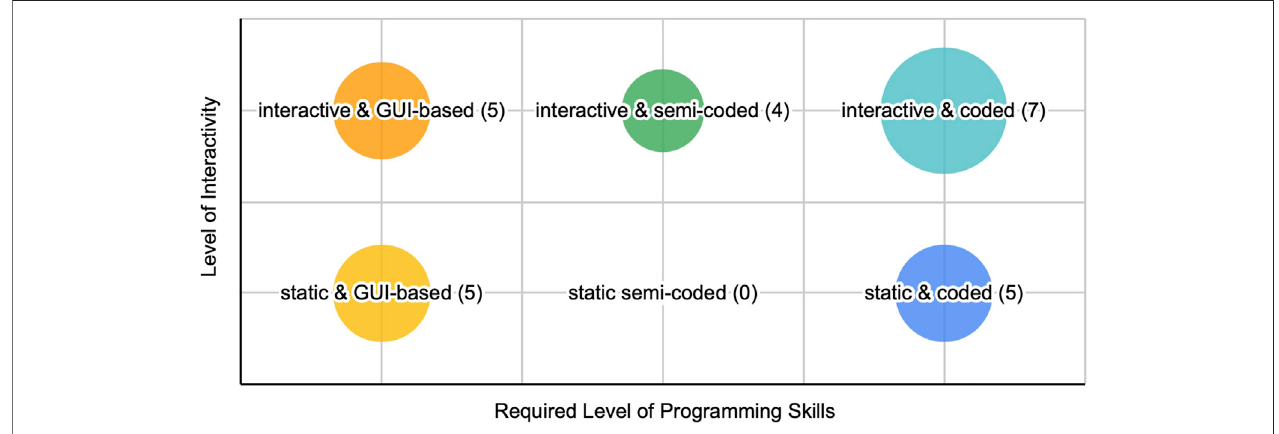
FIGURE 5 | Required programming skills and provided interaction possibilities.